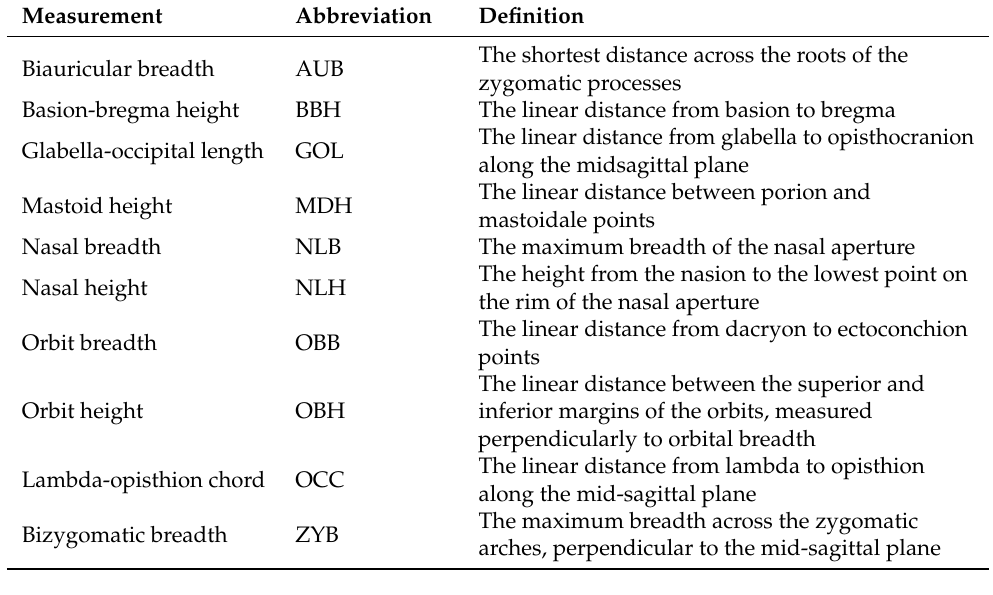
Table 1. Cranial measurements used in the analysis, abbreviations, and definitions.